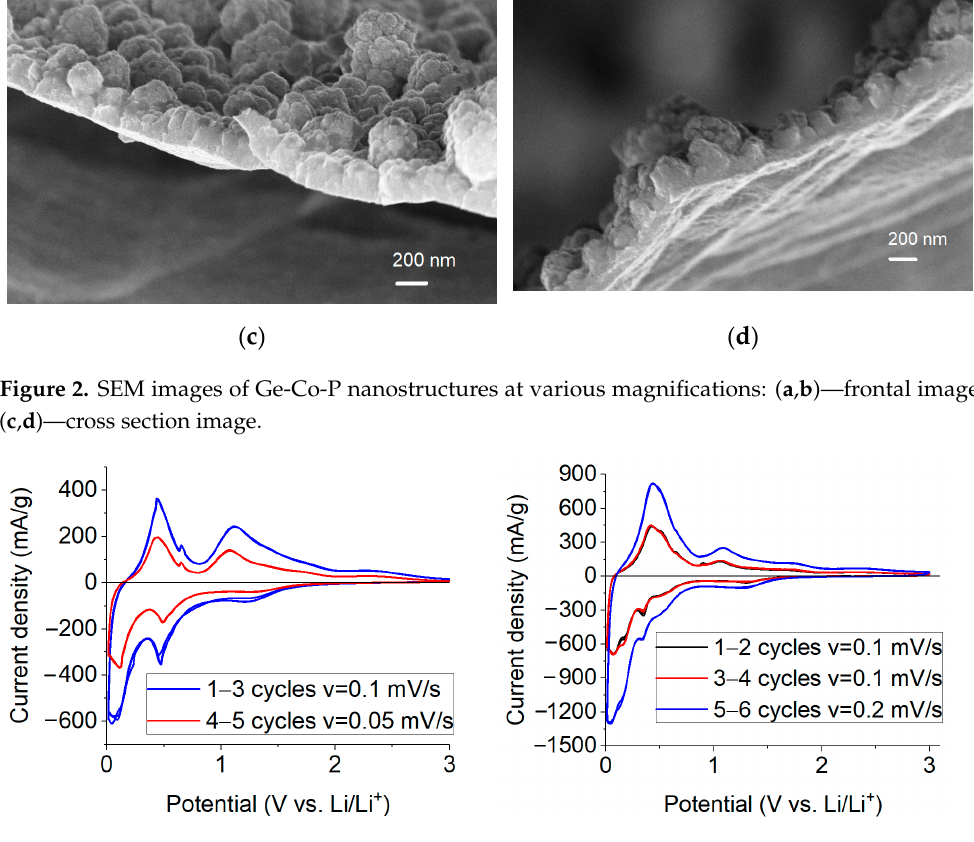
Figure 4. Charge and discharge curves for sodium insertion/extraction into/from CoGe 2 P 0.1 at vari- ous current densities. One can clearly behold two clear (although inclined) plateaus at anode curves at po- tentials ca. 0.5 and 1.1 V, which is in good agreement with peaks at CVs. Noteworthy is the rather weak dependence of discharge capacity on C-rate: discharge capacity at current densities 25, 50, and 100 mA/g amounted to 855, 825, and 780 mAh/g. Theoretic specific capacity of CoGe 2 provided the supposition that germanium is active, and cobalt is inac- tive components amounts to 1100 mAh/g. Thus, the experimental specific capacity reaches 77% from theory. Intriguingly, the shape of galvanostatic curves in Figure 4 notably dif- fers from the shapes of galvanostatic curves for plain Ge [34] and GeP [21], despite the similarity of corresponding CVs. 2.3. Electrochemical Studies of Sodium Insertion/Extraction CVs for processes of sodium insertion/extraction into/from Ge-Co-P nanostructures are shown in Figure 5a. Again, this figure displays three consecutive curves at the